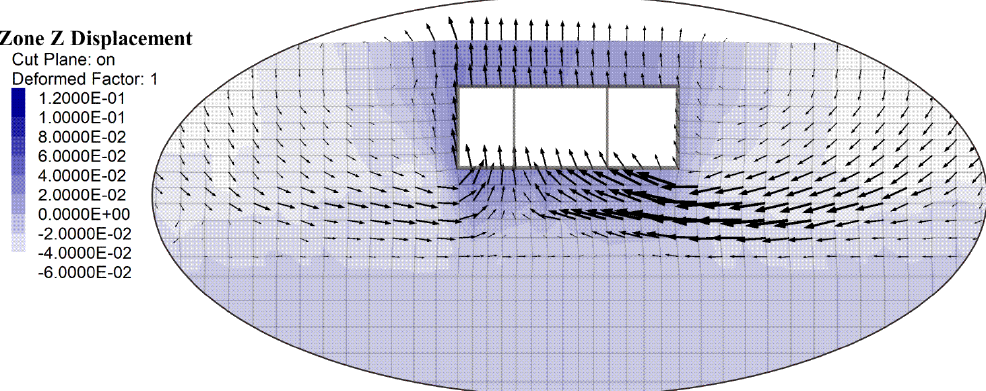
Figure 10. Vertical displacement and displacement vector of the 2 m burial depth model at the end of the earthquake.